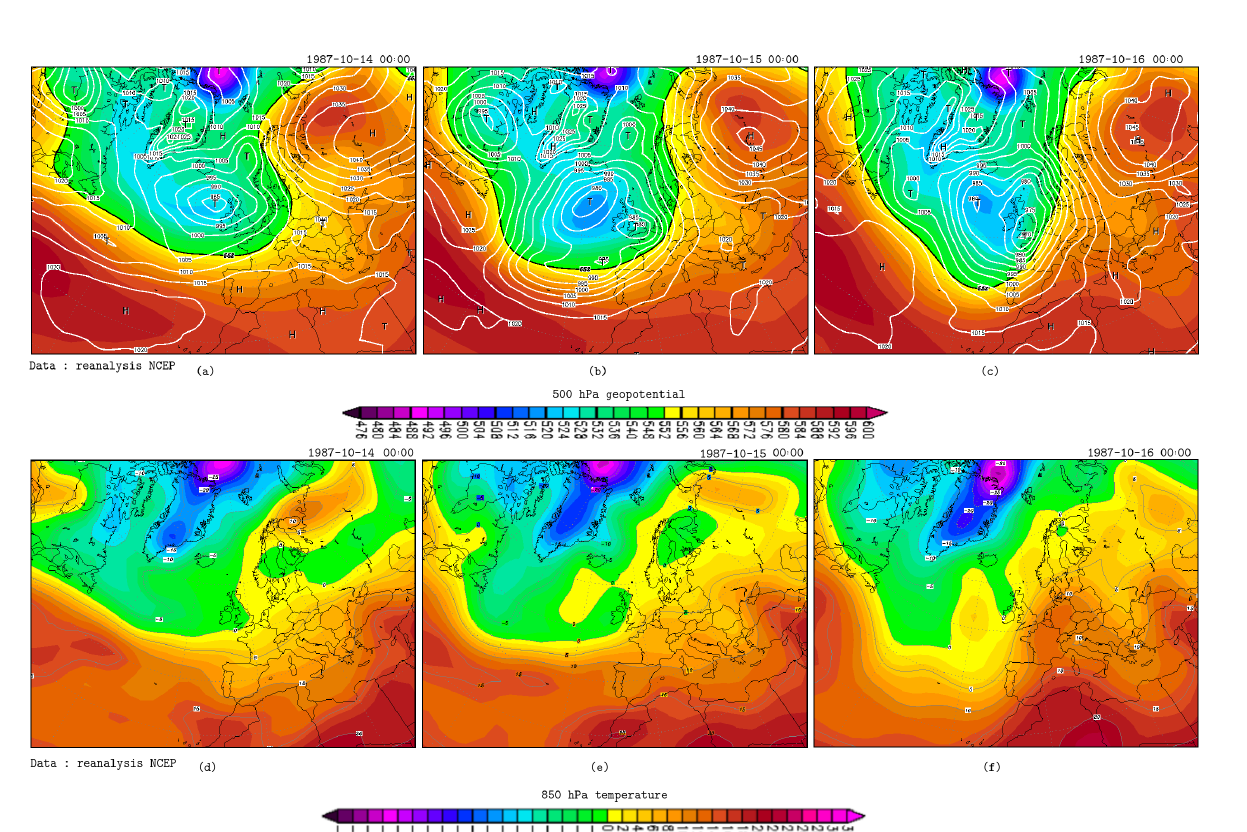
Figure A2. Showing the 500hPa geopotential field together with sea level pressure (a–c) and 850hPa temperature (d–f) in the Great Storm of 1987 event from 14 to 16 October. The figure highlights the cooperative linkage between a trough and low-level baroclinicity in the rapid development of the cyclonic